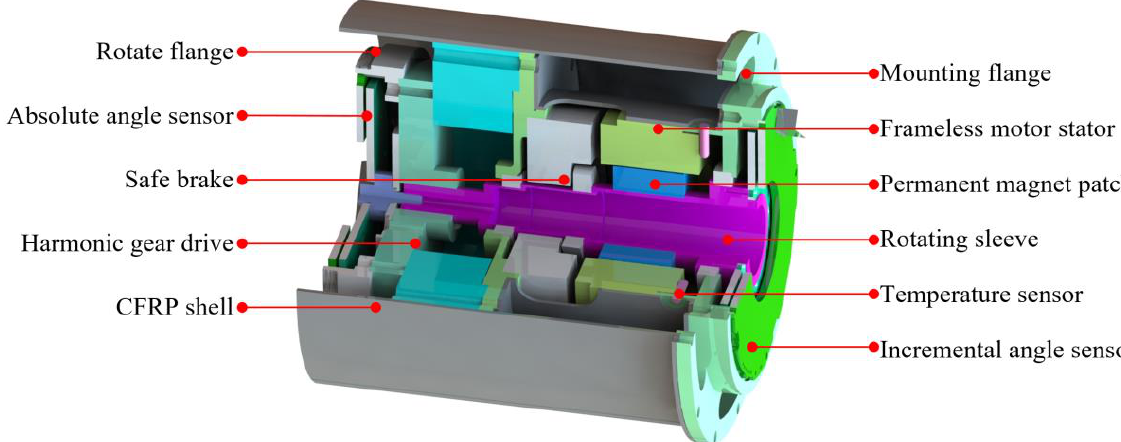
Figure 16. Overall structure of GIERM.